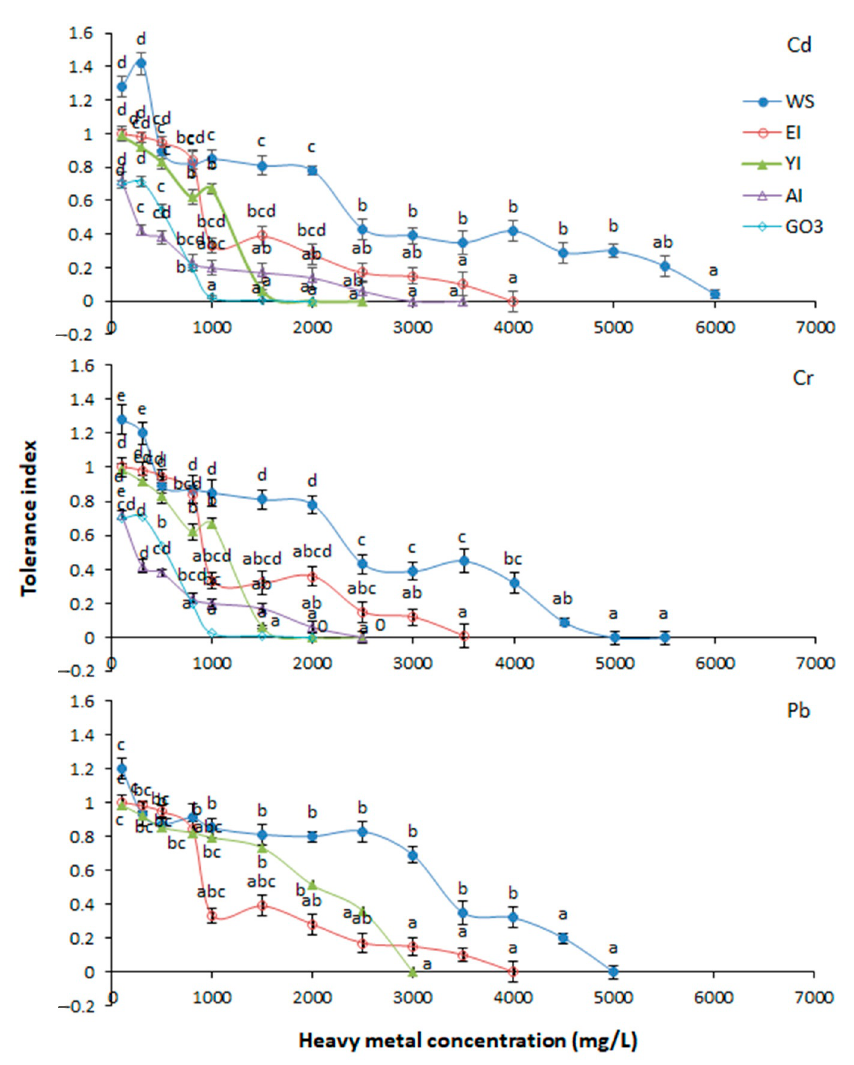
Figure 2. Tolerance index of fungi strains under various heavy metal concentrations. Columns denote the mean values and bars indicates standard error. Different letters show statistically significant different values ( p < 0.05) from each other as calculated by Tukey’s honestly significant difference test. Means with same letters within the isolate groups are not significantly different at Honestly Significant Difference (HSD (0.05) ) Aspergillus sclerotiorum (A1), Aspergillus aculeatus (E1), Aspergillus niger (G03), Komagataella phaffi (WS), and Trichoderma harzianum (Y1).